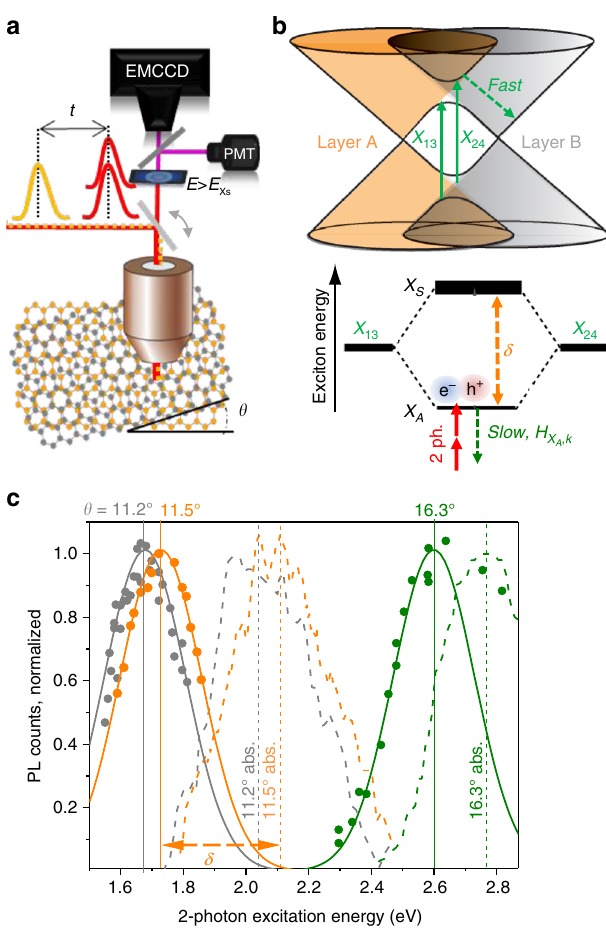
Fig. 1 θ -tunable photoluminescence. a Setup for 2-photon PL microscopy on t BLG with fi lters passing E ≥ E t is used only for transient X S . The delayed pulse, absorption con fi rmation of the exciton binding energy. b Anticrossing band regions give two degenerate interlayer vHs transitions, X 13 and X 24 . In an exciton model (lower panel): rehybridized transitions give a symmetric, bright ( X S ) and a 2-photon accessible antisymmetric ( X A ) states. c PLE peaks (circles) tune with θ = 11.2°, 11.5°, and 16.3°, and suggests 2-photon states, X A lying δ -below dashed linear absorption peaks, X